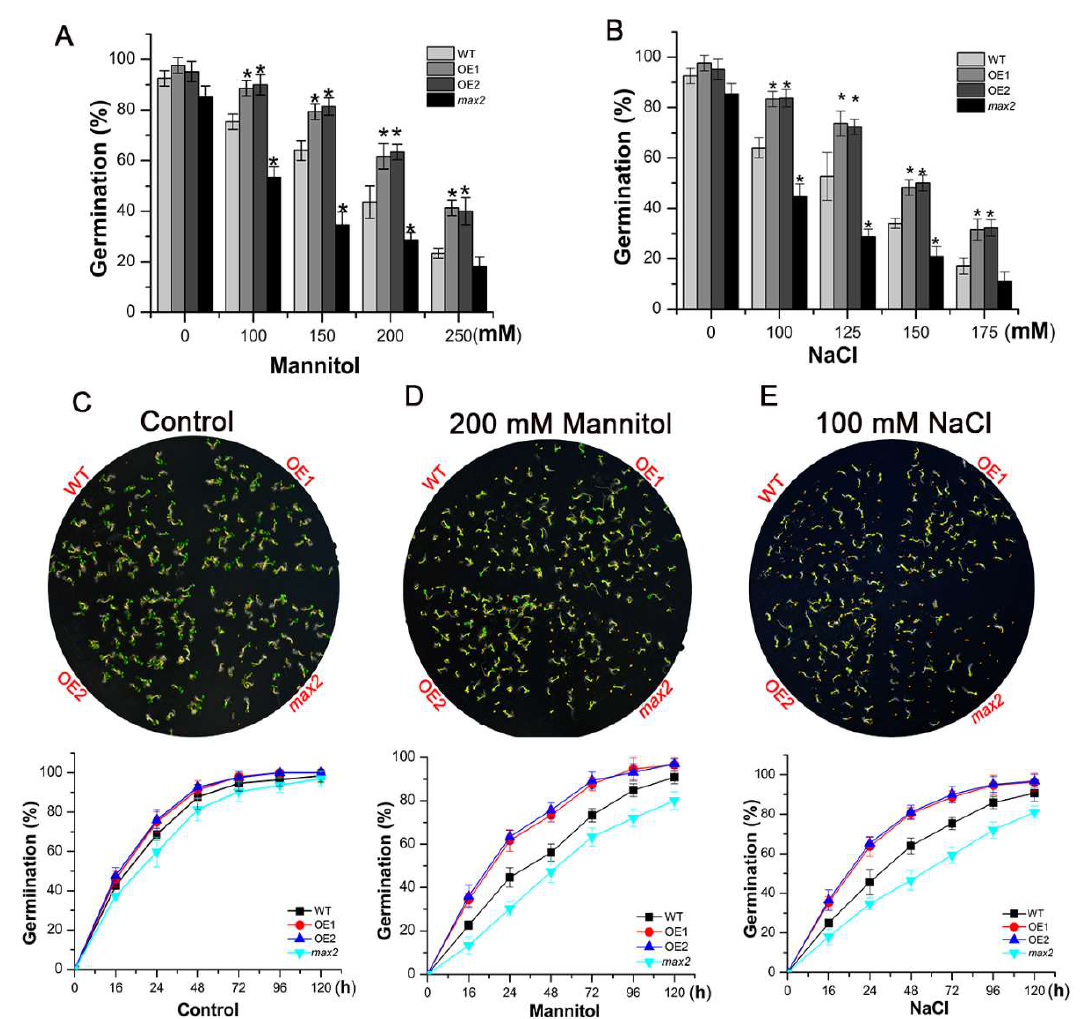
Figure 6. SsMAX2 OE lines exhibited higher salt and osmotic stress tolerance during the seed germination stage. ( A , B ) Seed germination rate of the SsMAX2 OE lines, max2 , and WT under various concentrations of NaCl and mannitol treatment; ( C – E ) Time-course assay of the seed germination of different lines under 200 mM mannitol and 100 mM NaCl treatment. Data are presented as means ± SD of three biological replicates. Significant differences between WT and the other groups were determined by Student’s t -test. Significance level: * p < 0.05.